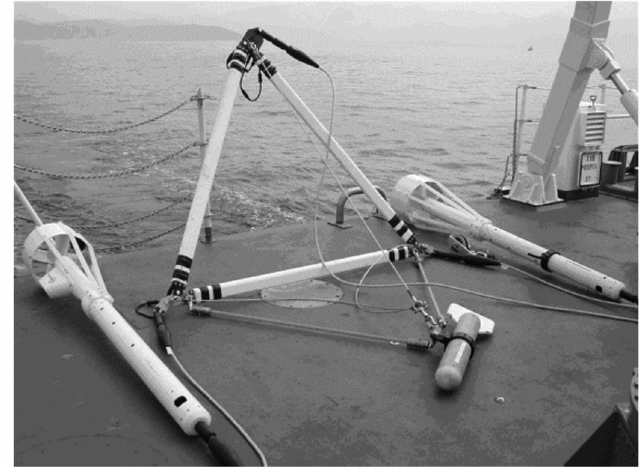
Fig. 2. Instrumentation used for the transverse gradiometric array; the two sensors, the ballast and the triangu- lar frame are